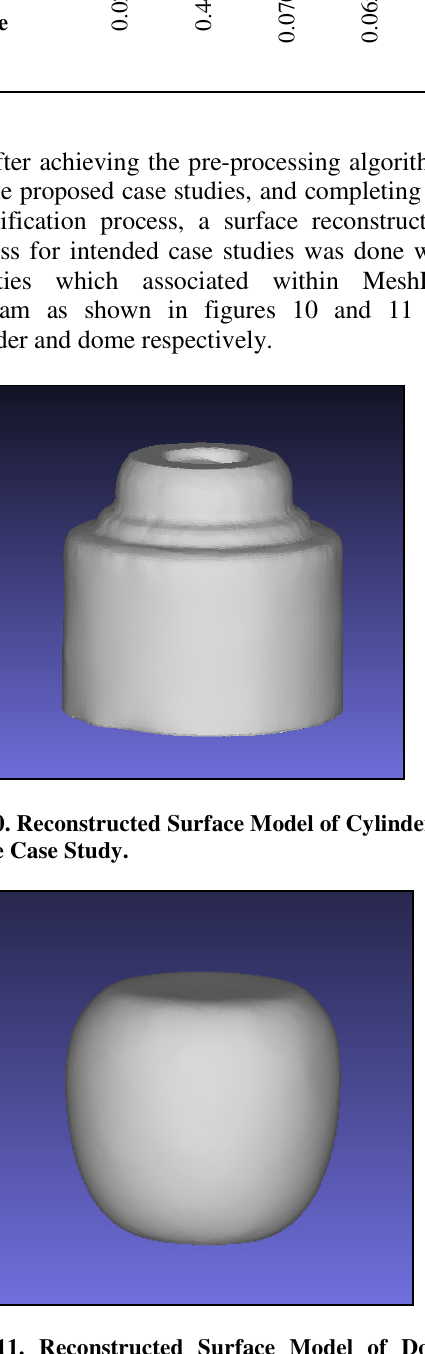
Fig. 11. Reconstructed Surface Model of Dome Shape Case